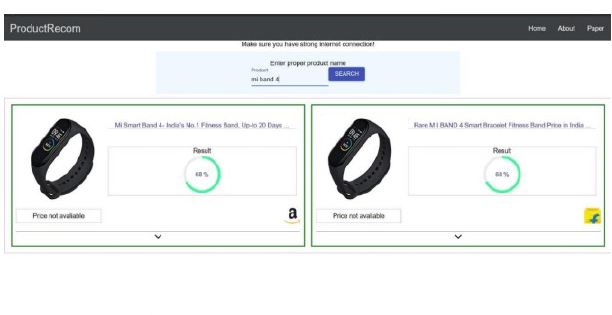
Fig. 5 . Recommendation with same